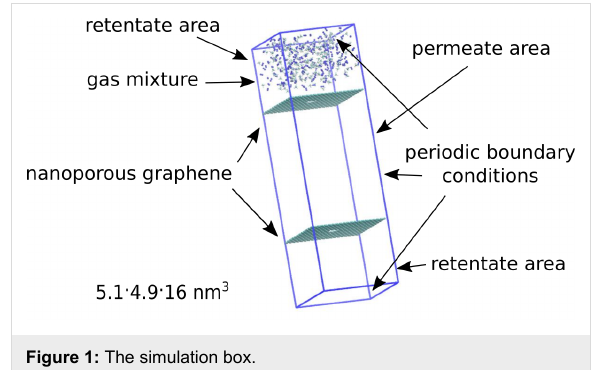
Figure 1: The simulation